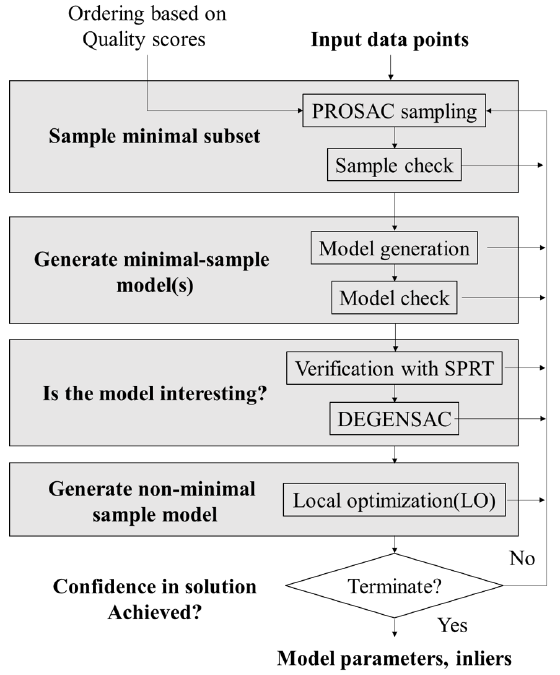
Figure 1. Flowchart of